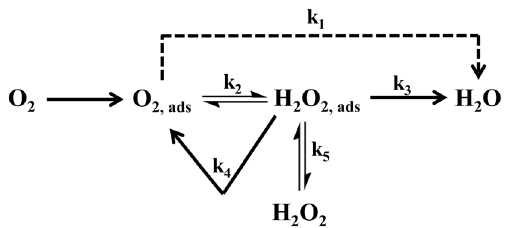
Figure 1. Mechanism and pathways for the oxygen reduction reaction.